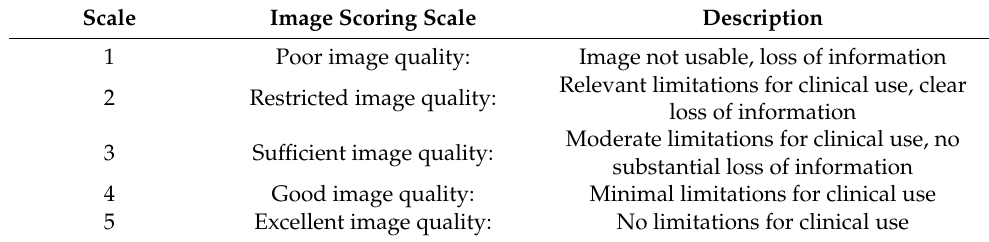
Table 3. VGA-based scale for scoring image quality.